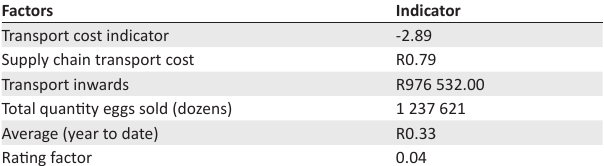
TABLE 22: T ransport cost.